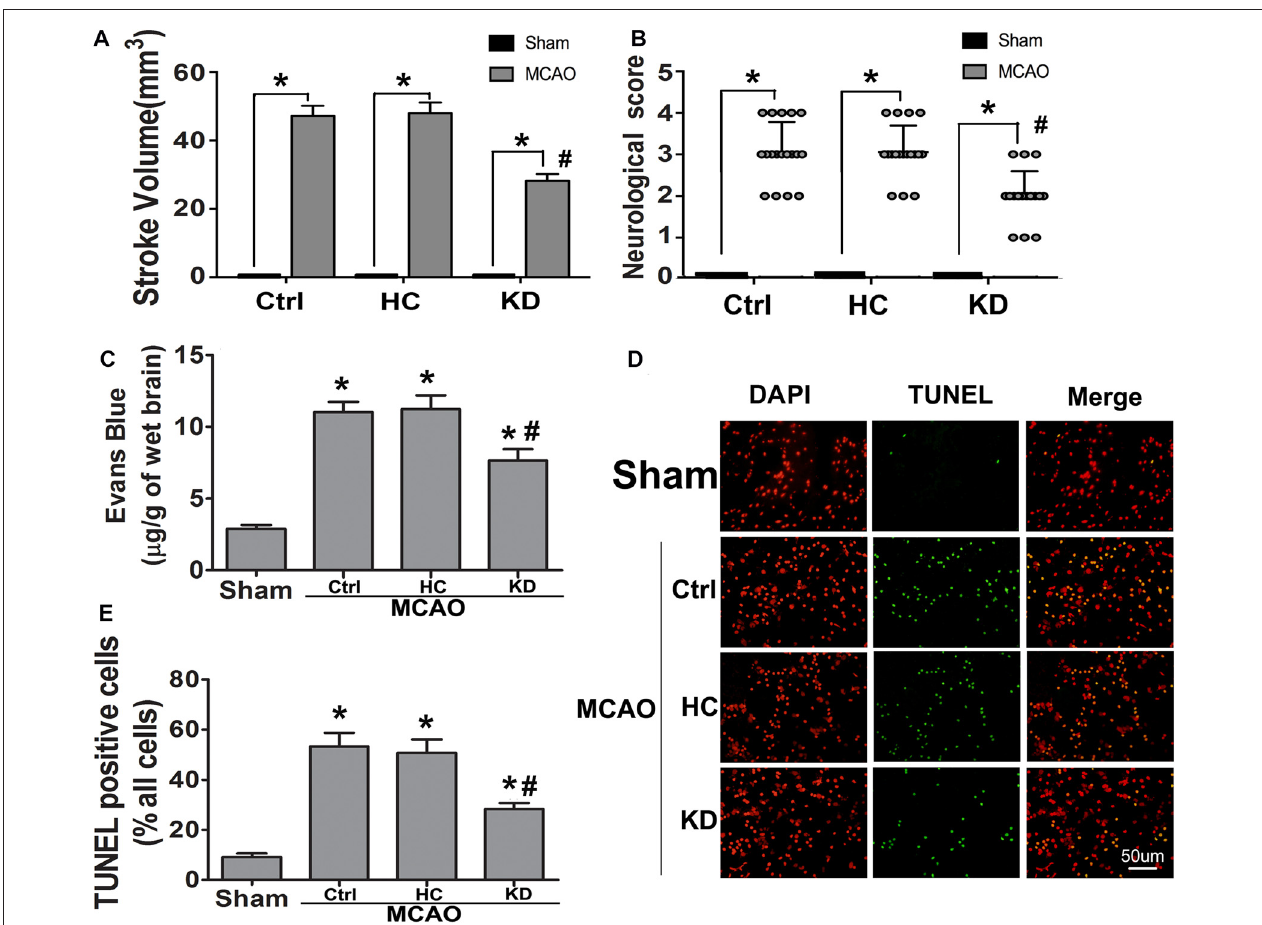
FIGURE 1 | Ketogenic diets (KD) improved ischemic tolerance in middle cerebral artery occlusion (MCAO) mice. Sham-operated and MCAO mice were fed with different diet protocols, and infarct volume ( A , n = 6 per group), neurological score ( B , n = 18 per group), and blood-brain barrier (BBB) permeability ( C , n = 6 per group) were assessed. (D) Fewer TUNEL-positive cells were observed in KD-fed MCAO mice (Scale bar: 50 µ m). Brain sections were subjected to TUNEL staining and positive cells were counted (nuclei: DAPI). (E) Quantification of TUNEL-positive cells in different groups ( n = 6 per group). Data are shown as mean ± standard error of the mean (SEM); ∗ P < 0.01 vs. sham-operated mice, # P < 0.05 vs. MCAO group.